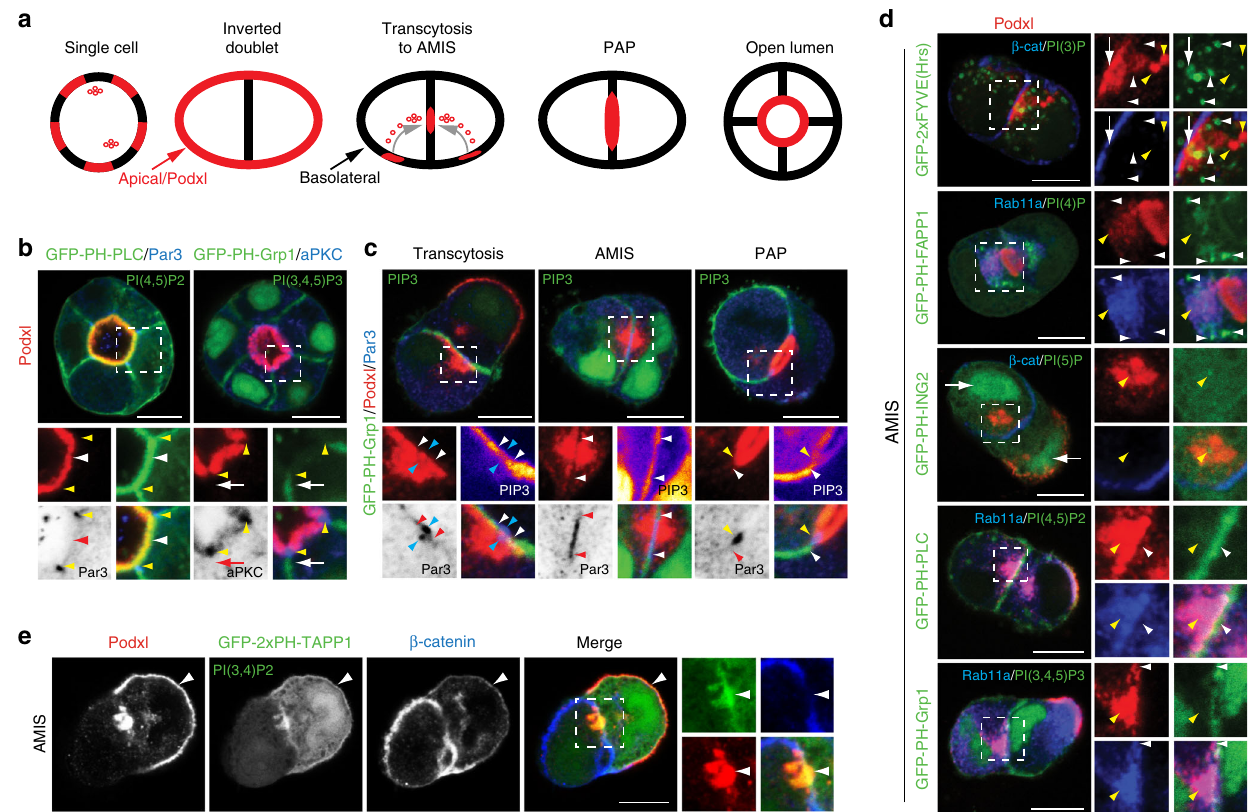
Fig. 1 PIP distribution during polarization. a Cartoon of cyst development, showing progression from single cell through inverted doublet, transcytosing vesicles/AMIS (Apical Membrane Initiation Site), PAP (Pre-apical Patch) and Open Lumen stages. Red, apical/Podxl; black, basolateral. b PI(4,5)P 2 [EGFP- PH-PLC] and PI(3,4,5)P 3 [PIP 3 , EGFP-PH-Grp1] (both green) localization in MDCK cysts with an open lumen (48 h), stained for Podxl (red) and either Par3 (left) or aPKC (right) (both blue or inverted greyscale). White arrowhead (red in inverted color panels), apical PI(4,5)P 2 ; white arrows (red in inverted color panels), basolateral PIP 3 ; yellow arrowheads, tight junction-localized Par3 or aPKC. In all instances, bottom panels are higher magni fi cation of split color images from boxed regions. c PIP 3 [EGFP-PH-Grp1], Podxl and Par3 localization during lumen initiation (12 – 24 h). Note the single Par3 punctum forming adjacent the cell – cell contact in each cell (blue arrowheads). White arrowheads (red in inverted color panels), edge of PIP 3 -enriched PM; yellow arrowheads, tight junction-localized Par3. PIP 3 in magni fi ed boxes has been pseudocoloured to indicate intensity of labeling. d PI(3)P [EGFP-2xFYVE], PI(4) P [EGFP-PH-FAPP1], PI(5)P [EGFP-PH-ING2], PI(4,5)P 2 [EGFP-PH-PLC] and PIP 3 [EGFP-PH-Grp1] localization in cysts at the AMIS stage, stained for Podxl and either β -catenin (panels 1 and 3) or Rab11a (panels 2, 4, 5). Note the PI(3)P vesicles forming below the cell – cell contact near the β -catenin-depletion site (white arrow) and the absence of each PIP in Podxl-positive vesicles (yellow arrowheads). White arrowheads, PIP localization. e PI(3,4)P 2 [EGFP- 2xPH-TAPP1] localization in MDCK cells at the AMIS stage, stained with Podxl and β -catenin. Arrowheads, Podxl at ECM-abutting surface and AMIS. Far right panels are higher magni fi cation of split color images from the boxed region. All scale bars, 10 µ